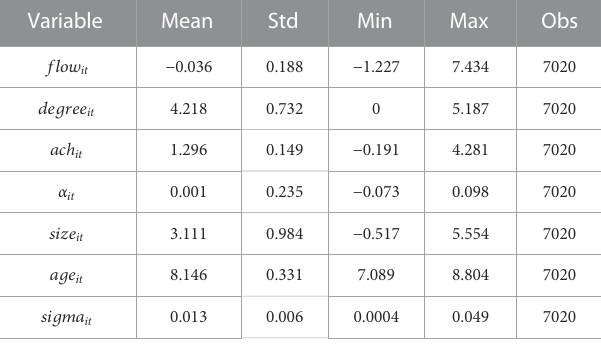
TABLE 2 Descriptive statistics of the total